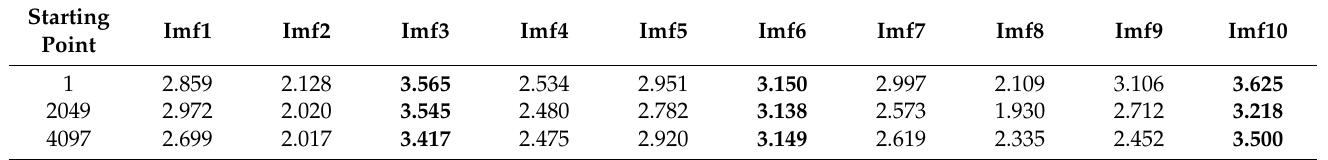
Table 4. The kurtosis value of each mode of the inner ring fault.